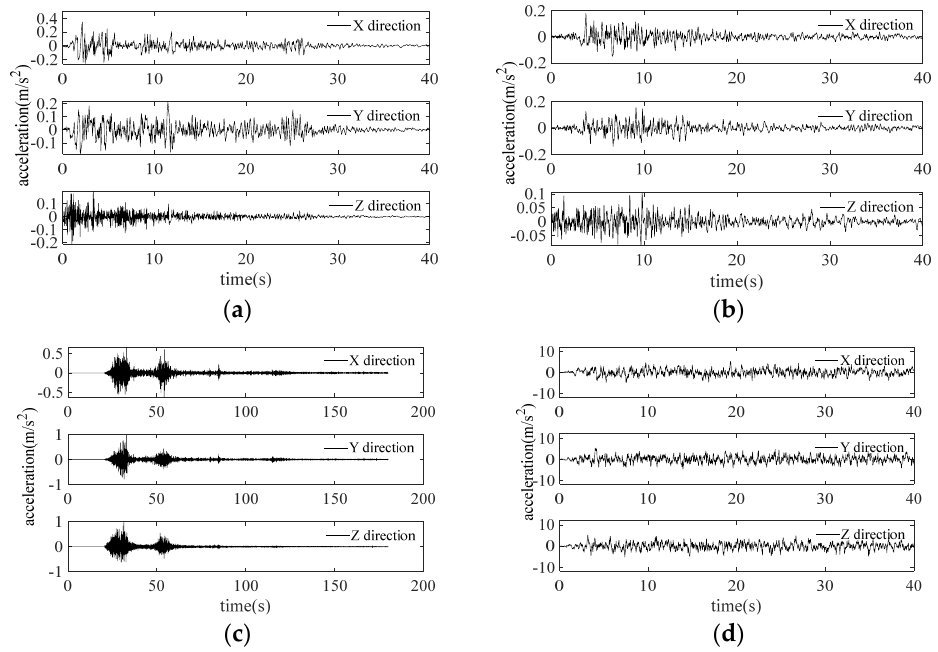
Figure 3. Time − history curve of the seismic wave: ( a ) El Centro wave; ( b ) Taft wave; ( c ) Wolong wave; ( d ) Artificial wave.